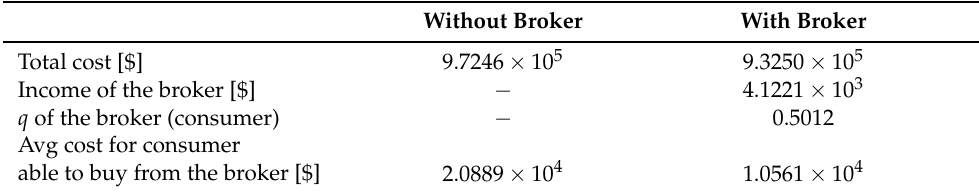
Table 7. Results of numerical tests—market with broker.